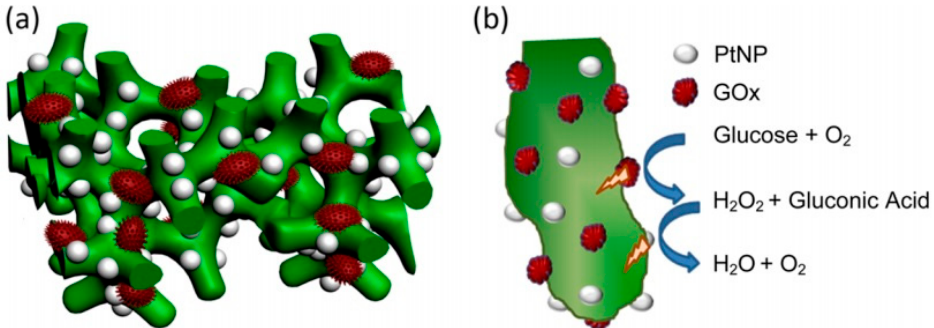
Figure 4. ( a ) Schematic representation of the 3D heterostructure of the PtNP/PANI hydrogel, in which the PANI hydrogel acts as a matrix for the immobilization of the GOx enzyme and homogeneous loading of PtNPs; ( b ) A 2D scheme showing the reaction mechanism of the glucose sensor based on the PtNP/PANI hydrogel heterostructure. Reprinted with permission from [41]. Copyright 2013, American Chemical Society. GOx: glucose oxidase.